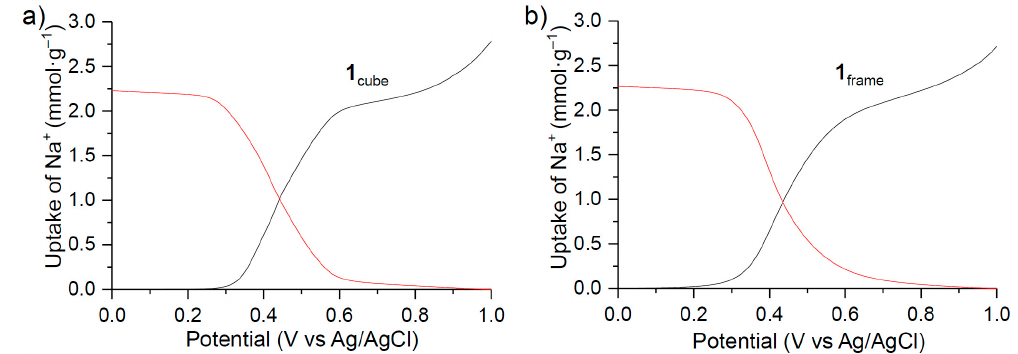
Figure 9. ( a ) Accommodation–release curves for Na + ions in 1 cube against the potential (vs. Ag/AgCl). ( b ) Accommodation–release curves for Na + ions in 1 frame against the potential (vs. Ag/AgCl).